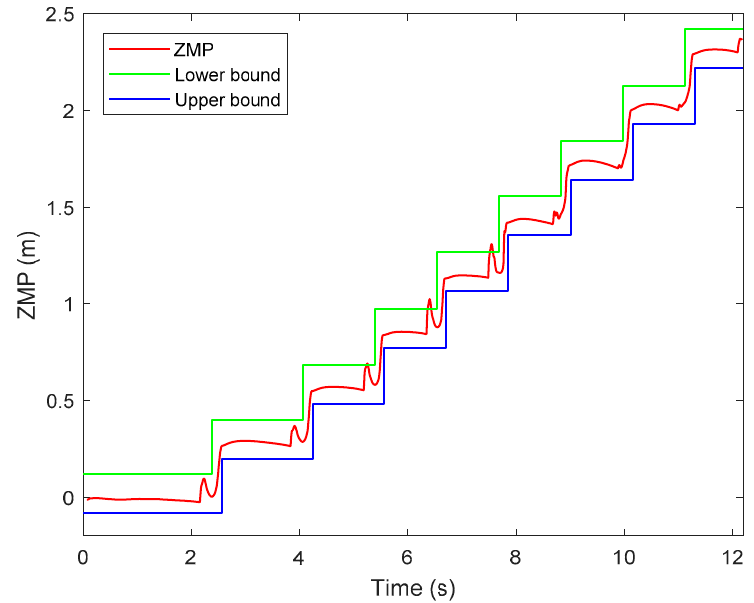
Figure 21. ZMP trajectory in the second simulation.